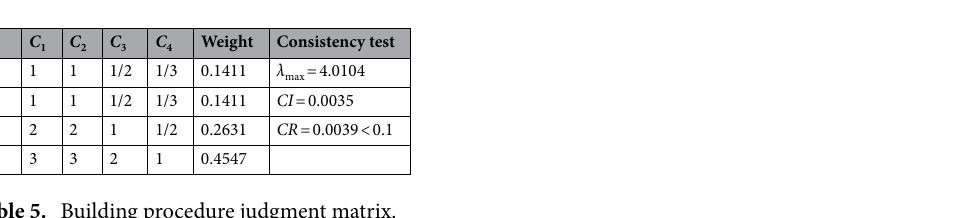
Table 5. Building procedure judgment matrix.